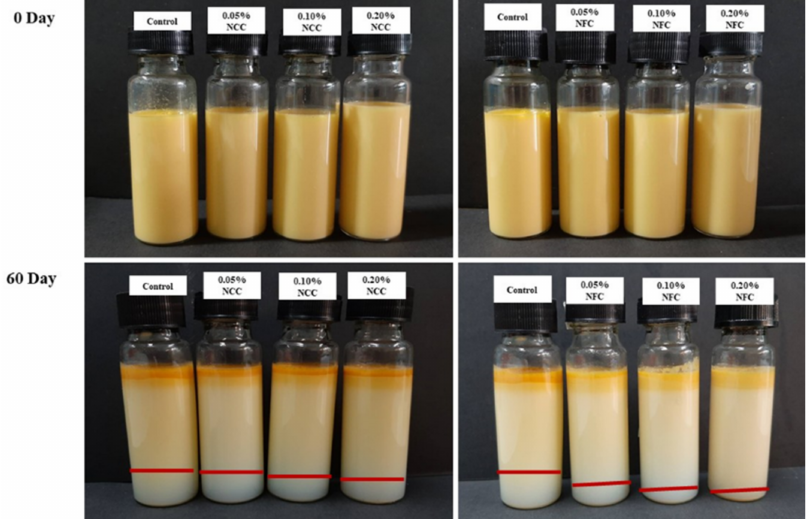
Figure 2. Appearance of 10% O/W emulsions containing β -carotene stabilized by NCC or NFC at various concentrations at 0.05, 0.10, and 0.20% w / w at 0 day and 60 days of storage time at room temperature (25 ◦